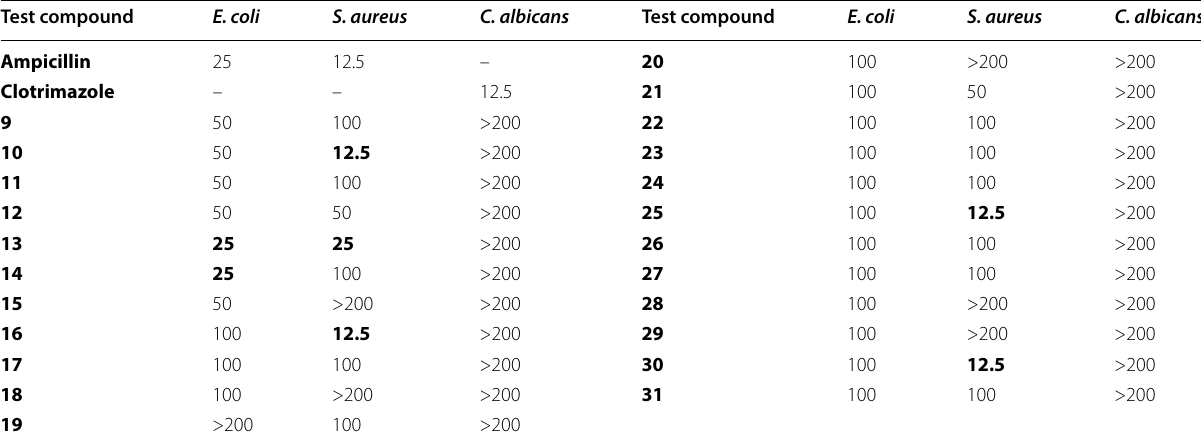
Table 1 Minimal inhibitory concentration (MIC) of test compounds in μg/mL Test